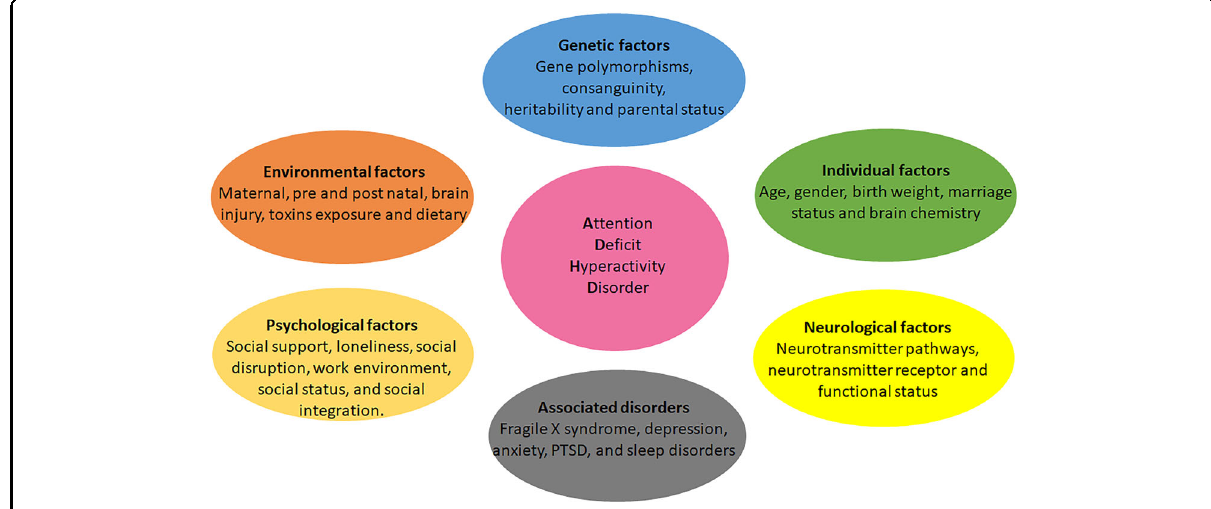
Fig. 1 Factors affecting ADHD pathophysiology. Different factors such as genetic, in particular, gene polymorphisms, environmental factors, psychological factors, individual factors such as age, abnormality in various neurological pathways such as dopaminergic and serotonergic, and comorbidity with multiple disorders are associated with symptoms of attention-de fi cit hyperactivity